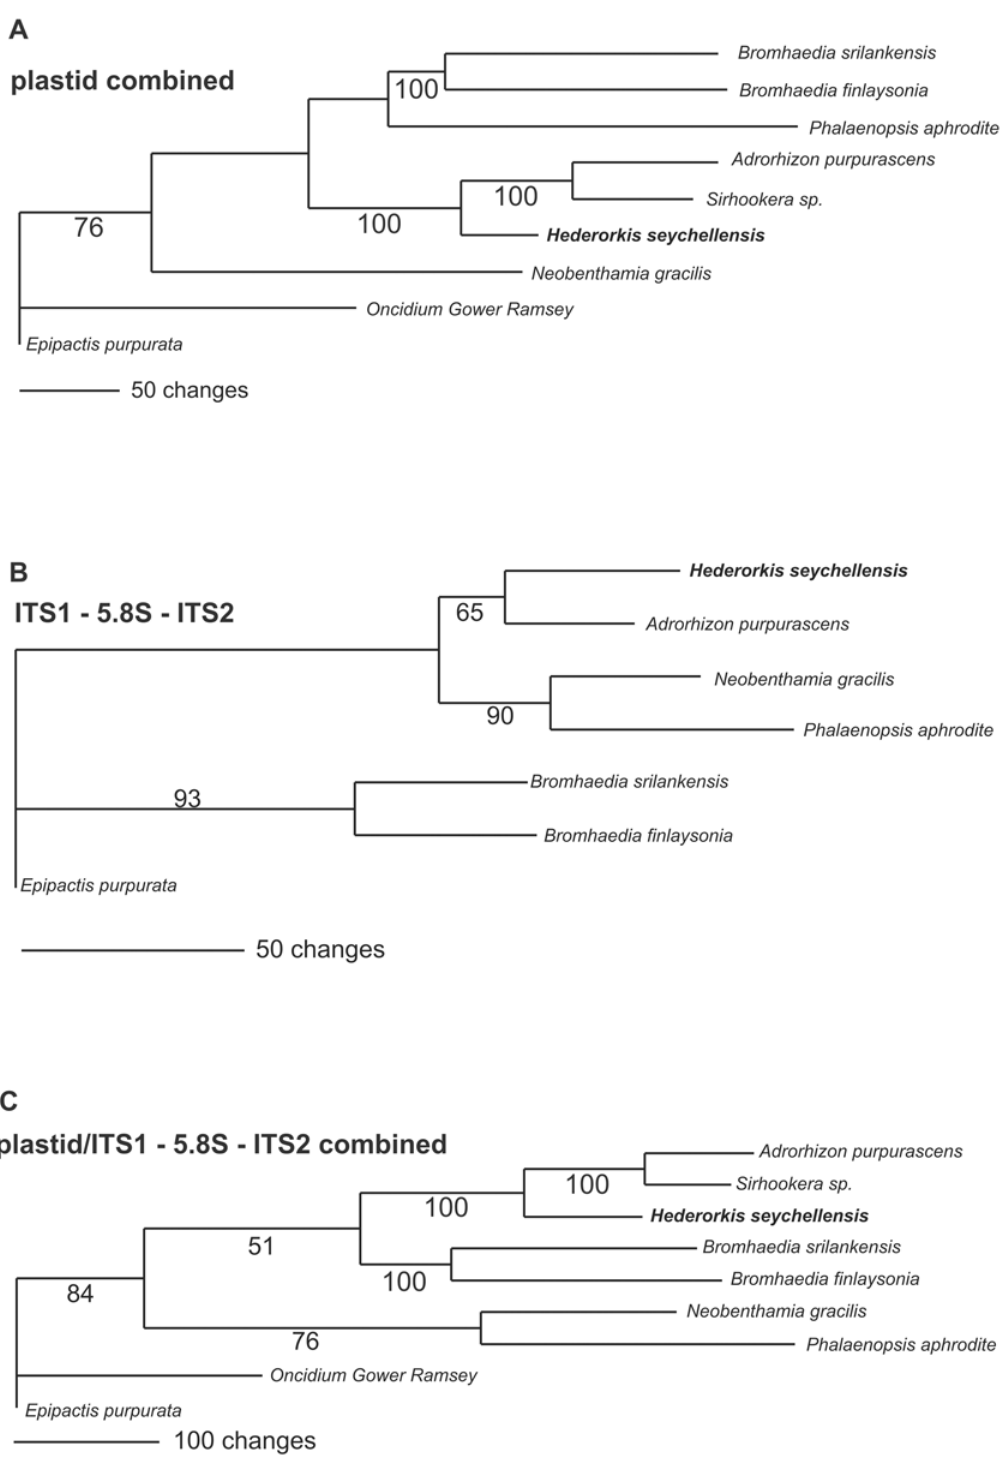
Fig 2. The most parsimonious tree (only one tree recovered in all parsimony analyses). Depicted as a phylogram to highlight the relative branch lengths in (A) plastid combined (matk + rpl 32 -trn L + rpl16 intron) analysis; (B) ITS1-5.8S-ITS2 analysis and (C) combined plastid and ITS1-5.8S-ITS2 analysis. Hederorkis seychellensis Thouars is highlighted in bold. The numbers above branches are Bootstrap percentages > 50.